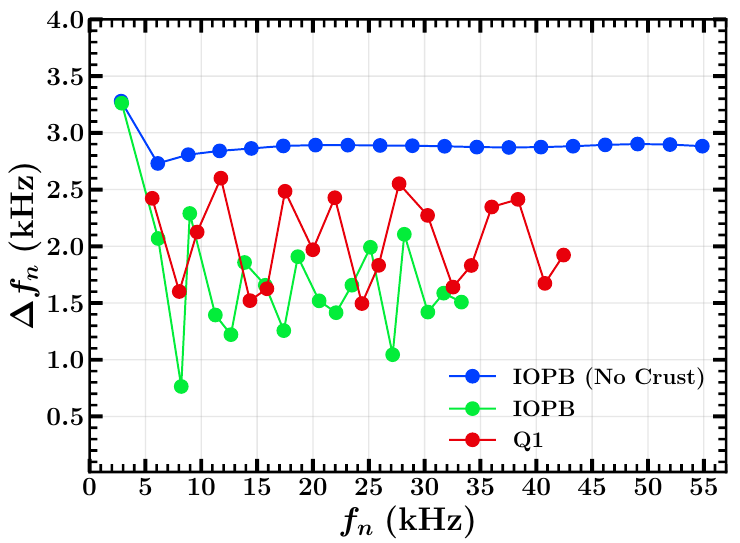
Figure 6. Large frequency separation vs. frequency comparing a unified hadronic EoS IOPB to a quarkyonic Q1 at 1.4 M (cid:12) . Furthermore, the nature of IOPB without a crust (at the same mass) is shown to analyze how drastically the behavior changes with the removal of the crust part from the